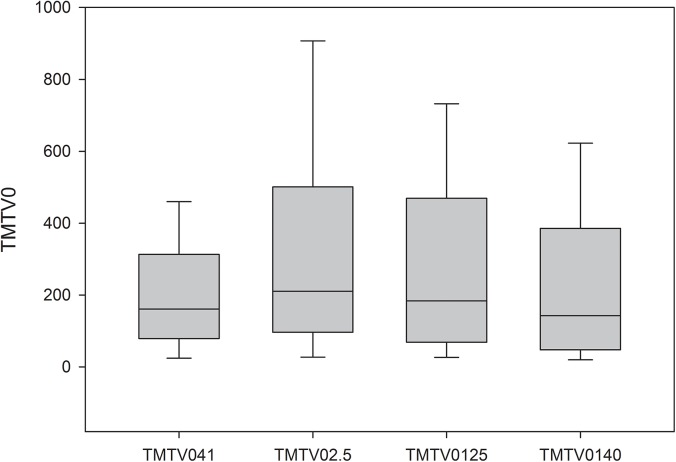
TMTV0 distribution according to each methodology.TMTV0 distribution with median (black lines), 25 to 75 percentile (grey boxes), 10 and 90 percentile (edges) according to each TMTV0 methodology.